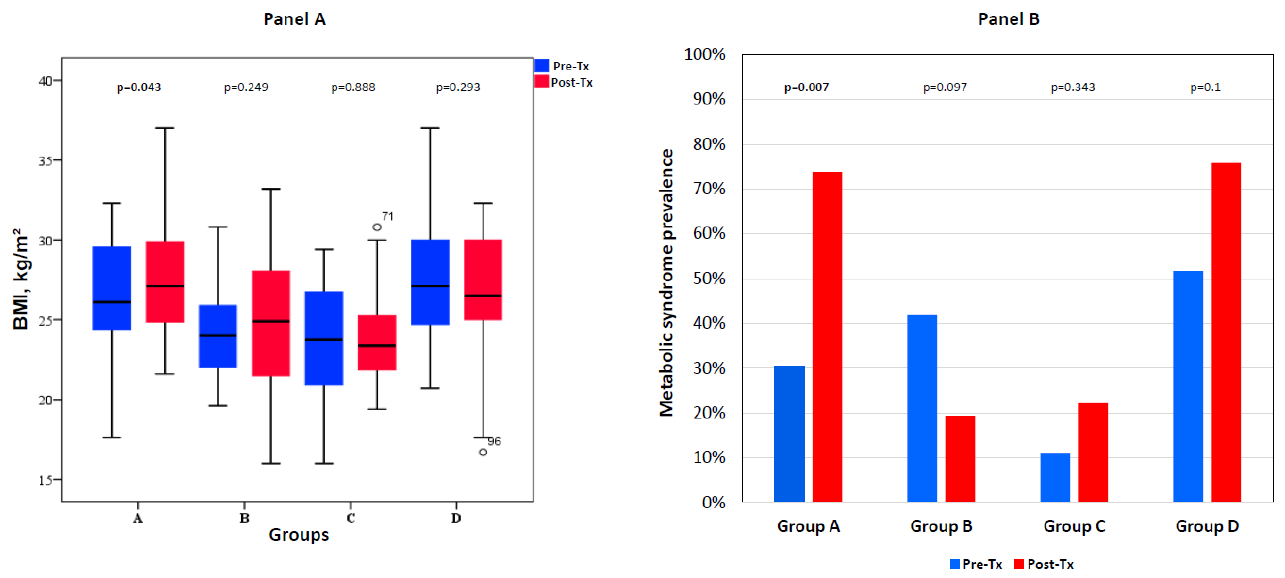
Figure 1. Changes in body mass index (BMI) [Panel A] and in metabolic syndrome prevalence [Panel B] from pre-transplant to post-transplant assessment in patients grouped according to changes in glucose metabolic state. Group A: worsened, including PTDM (N = 23); group B: improved (N = 31); group C: persistently normal glucose metabolism (N = 36); group D: unchanged pre-diabetes/DM (N = 29).